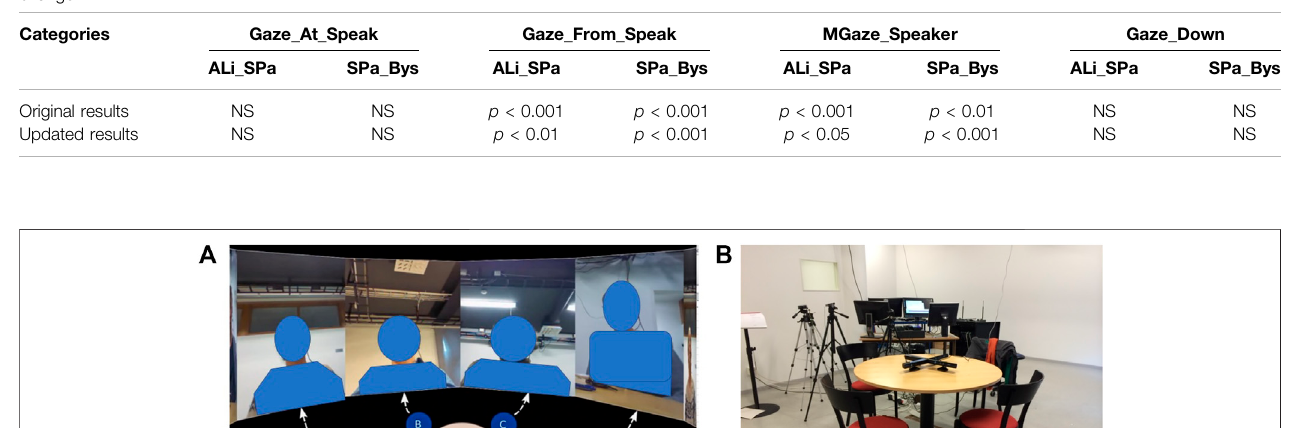
Figure 1B . Participants behaviors were recorded using a range of individually synchronized sensors. These include head-mounted microphones, Microsoft Kinect one sensors that are positioned at a distance of around 0.8 m away from participants, and high- resolution GoPro cameras.